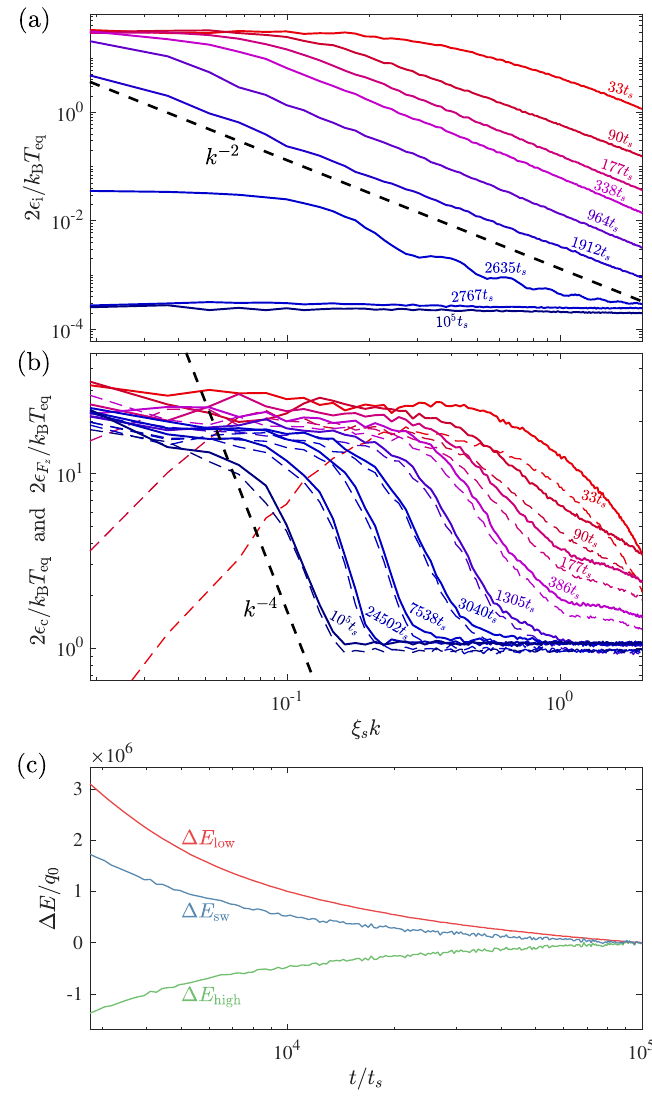
( k , t ) displays a Figure 2: (a) The evolving incompressible field spectral energy ε i predicted k − 2 scaling and rapidly drops after all vortices have annihilated. (b) The ( k , t ) (solid lines) shows three regions: evolving compressible field spectral energy ε c a persistent high temperature long wavelength region with a temperature approxi- mately equal to T ; a steep region with an approximate k − 4 scaling; and a short BKT ( k , t ) (dashed wavelength thermal region. The spectral energy of F excitations ε z F z ( k , t ) for times t (cid:166) 400 t lines) closely follows ε . The interacting F fluctuations s z c can mediate the thermalisation of the transverse spin waves. (c) The combined spec- ( t ) , is decomposed into a low tral energy of transverse and axial spin waves, E sw ( t ) , which decreases in time, and a high wavevector portion wavevector portion E low ( t ) , which increases in time, consistent with a cascade of energy from low to E high ( t ) also decreases in time indicat- high wavevectors. The total spin wave energy E sw ing energy flow away from spin